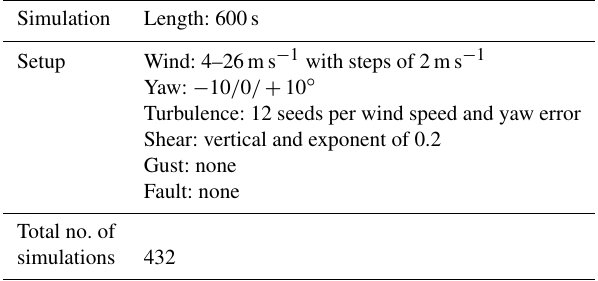
Table 5. Design load cases (DLC) 1.2 power production on normal turbulence load case simulation